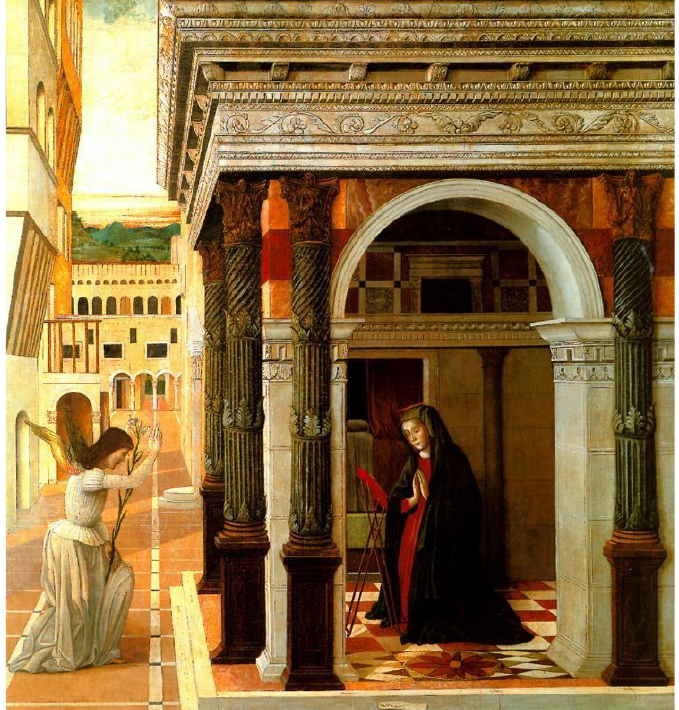
Figure 10. Gentile Bellini, The Annunciation , c. 1475. Thyssen-Bornemisza Museum. Madrid. The painter placed Mary inside the palace, kneeling in prayer before a lectern. At the same time, the angel, carrying the stem of lilies and pointing his right index finger towards the heights, remains on his knees outside the palace in the middle of the street.